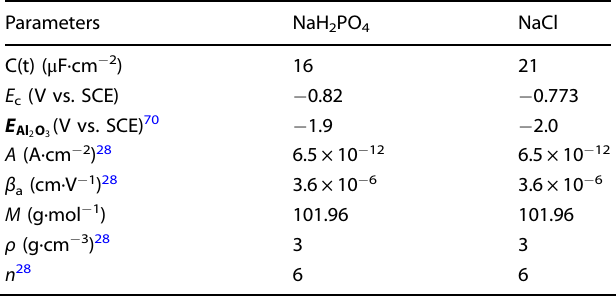
Table 1. Parameters used in the simulation of j hf in 0.62 M NaH 2 PO 4 and 3.5%wt NaCl. Parameters